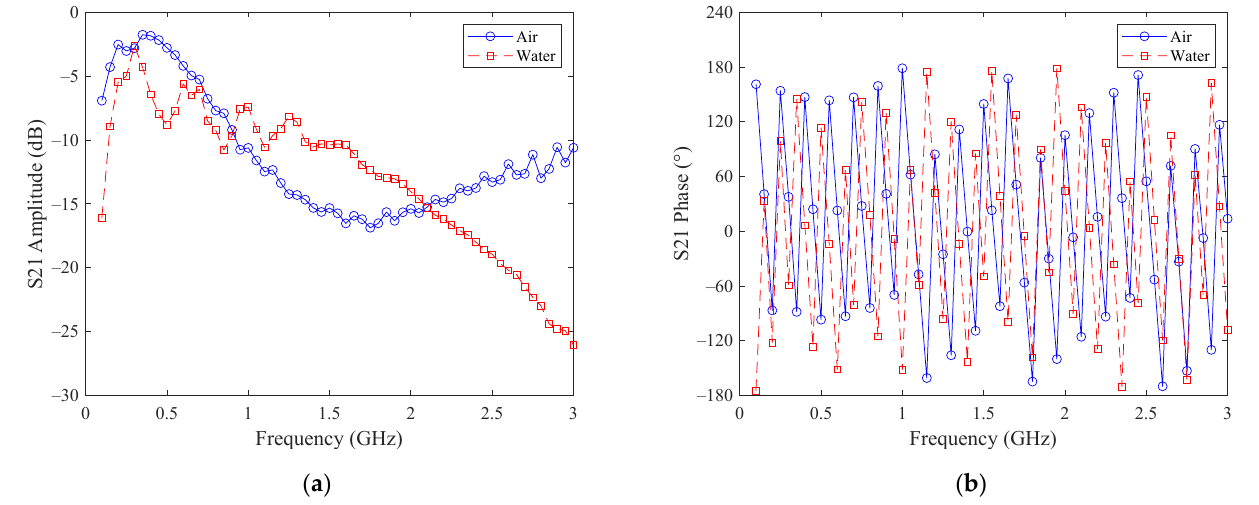
Figure 3. The scattering parameter figure of the microwave transmission system: ( a ) amplitude as a function of frequency; ( b ) phase as a function of frequency.